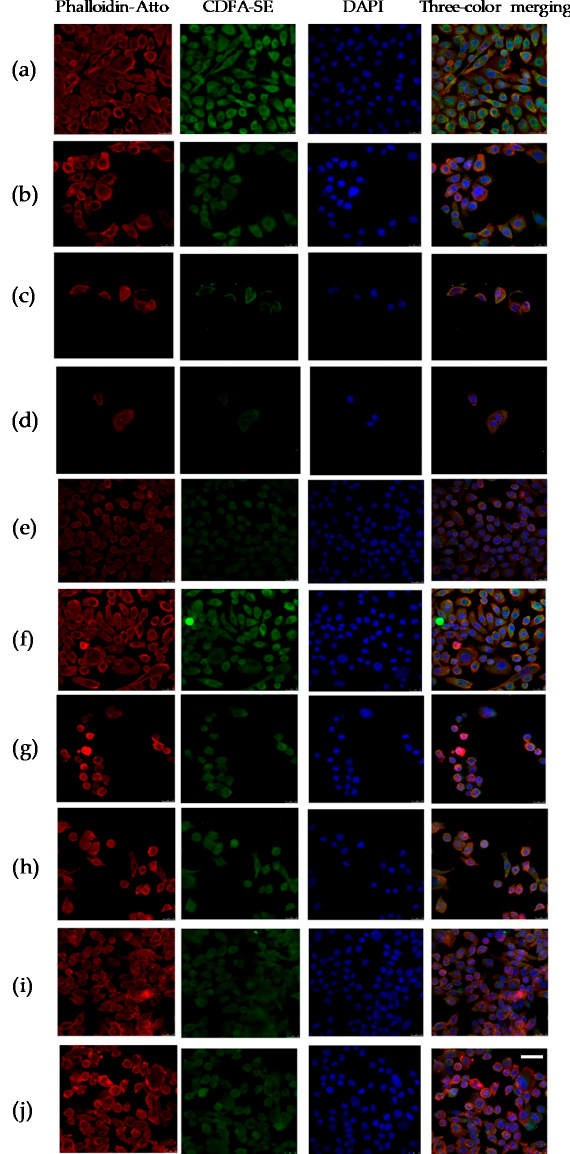
Figure 4. Cytopathic changes in PC-3 cells induced by the control treatment ( a ) or the treatment with DOCE 2 nM ( b ); AITC 20 µ M ( c ); AITC 20 µ M + DOCE 2 nM ( d ); SFN 30 µ M ( e ); SFN 30 µ M + DOCE 2 nM ( f ); IB 30 µ M ( g ); IB 30 µ M + DOCE 2 nM ( h ); PEITC 4 µ M ( i ); PEIT and C 4 µ M + DOCE 2 nM ( j ). Confocal images show green (carboxyfluorescein diacetate succinimidyl ester, CFDA-SE), red (Phalloidin ‐ Atto 647N), blue (4’, 6 ‐ diamidino ‐ 2 ‐ phenylindole, DAPI) and merge of three channels. The cells treated with AITC (20 µ M), SFN (30 µ M), IB (30 µ M), PEITC (4 µ M) and / or DOCE (2 nM) showed a predominantly rounded shape phenotype with DNA condensation. Scale bar = 100 µ